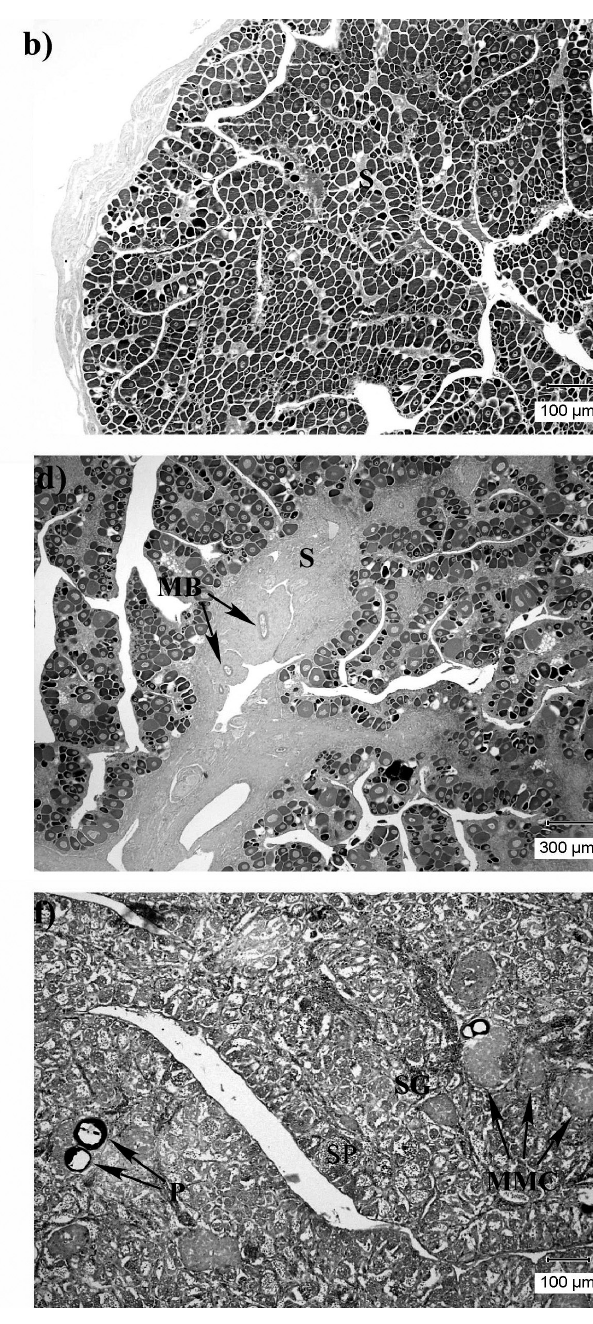
Fig . 1. – Sections of female and male Epinephelus marginatus gonads. a) Longitudinal section of an incompletely differentiated immature ovary (F1). Note the thread-like appearance, with previtellogenic oocytes (chromatin-nucleolus (CN) and perinucleolar (PN) stages) in the cortex and abundant stroma. b) Cross-section of a developing-immature ovary (F2), showing numerous previtellogenic oocytes inside closely packed lamellae and only scarce stroma (S) on the axis of the ovigerous fold. Ovarian lumen is very reduced. c) Cross-section of a ripe ovary (F5) showing a very advanced batch of hydrated oocytes (H) and new batches of vitellogenic oocytes (yolk granule (YG) stages I, II, and III). Melanomacrophage centres (MMC) and cysts of parasites (P) could also be seen. Note the abundance of stroma and the absence of female germ cells around the parasites. d) Cross-section of a resting ovary (F8), showing muscle bundles (MB), abundant stroma on the axis of the ovigerous fold, and postovulatory follicles (POF). Numerous previtellogenic oocytes can be seen. e) Cross-section of spawning testes (M3), showing numerous free spermatozoa (SP) in the lobule lumen (L) and inside spermatic sinuses (SS). f) Cross-section of resting testes (M4), showing free residual spermatozoa within the lobule lumen, many MMC , cysts of parasites and abundant cysts of spermatogonia